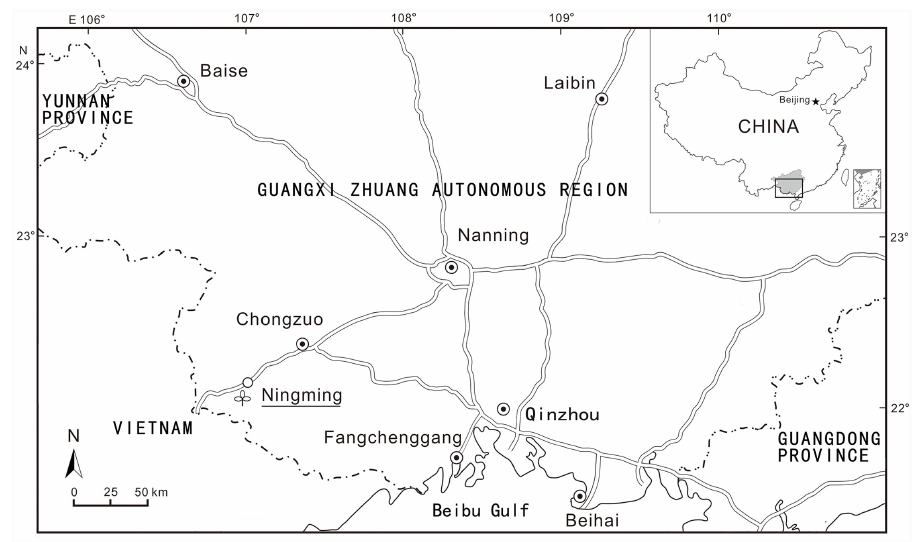
Fig 1. Sketched map showing the fossil locality (after